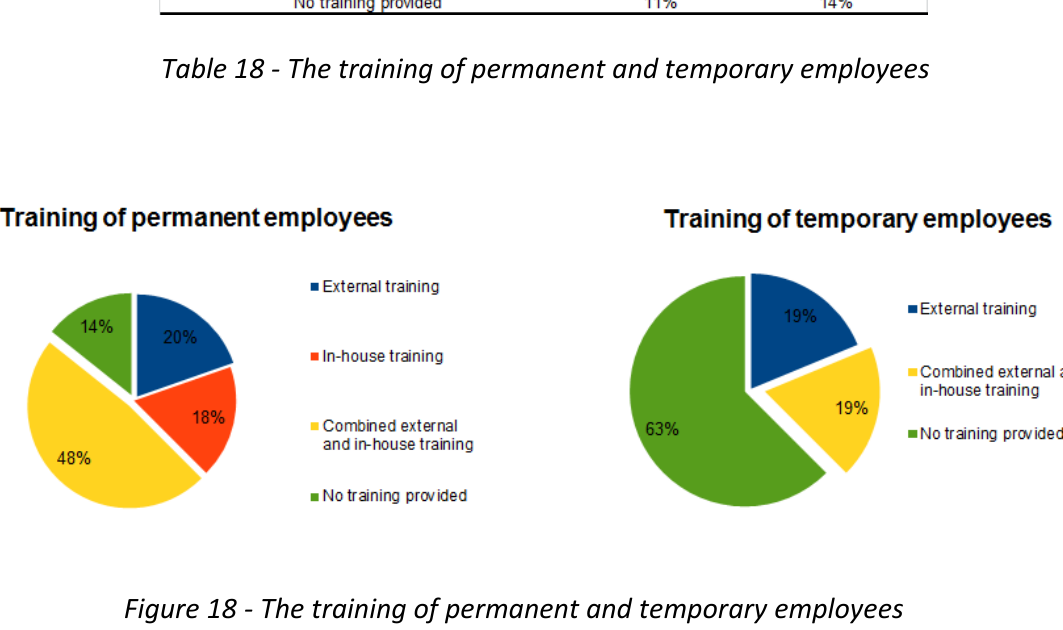
Figure 18 - The training of permanent and temporary